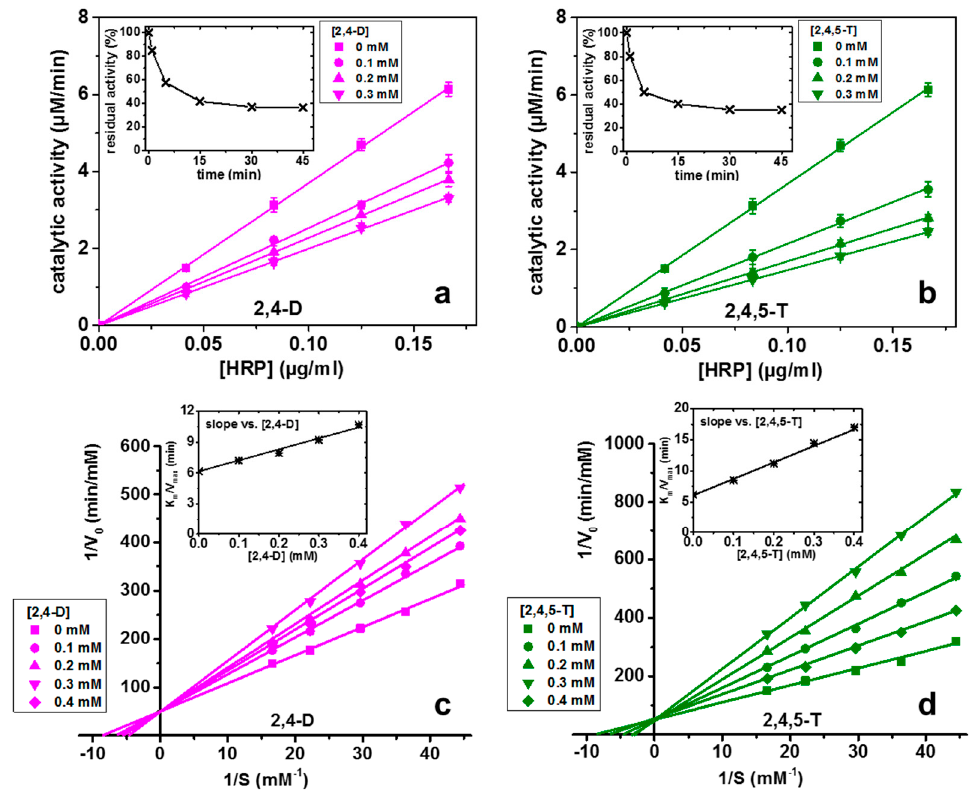
Figure 1. Top: Effect of 2,4-D ( a ) and 2,4,5-T ( b ) on the activity of HRP at different enzyme concentrations. Inset: Residual activity vs. time plots. Bottom: Lineweaver–Burk plots for the inhibition of 2,4-D ( c ) and 2,4,5-T ( d ) on the activity of immobilized HRP at different concentrations of pesticide. Inset: Secondary plots (slope vs. concentration and intercept vs. concentration) used for the determination of inhibition constants. Conditions: 10 mM phosphate-buffered saline pH 6.5, 25 ◦